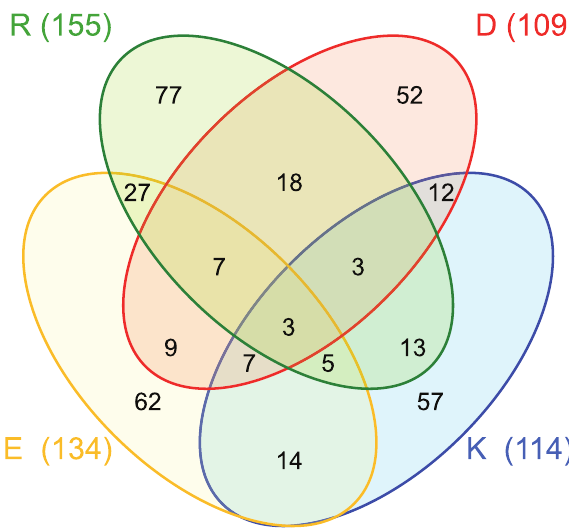
Figure 1. Venn diagram of TM segments (the central 19 residues) containing charged residues: Asp (D, red), Lys (K, blue), Glu (E, yellow) and Arg (R, green). The value in parenthesis is the total TM helices that contain at least one of such residues. The values inside the ellipses indicate the number of TM helices in each combination of these four aminoacids. For example, there are 57TMhelices withonlyLys as a charged residue, 12 helices with only Lys and Asp, 7 helices with Lys, Asp and Glu, and 3 helices with all four ionizable